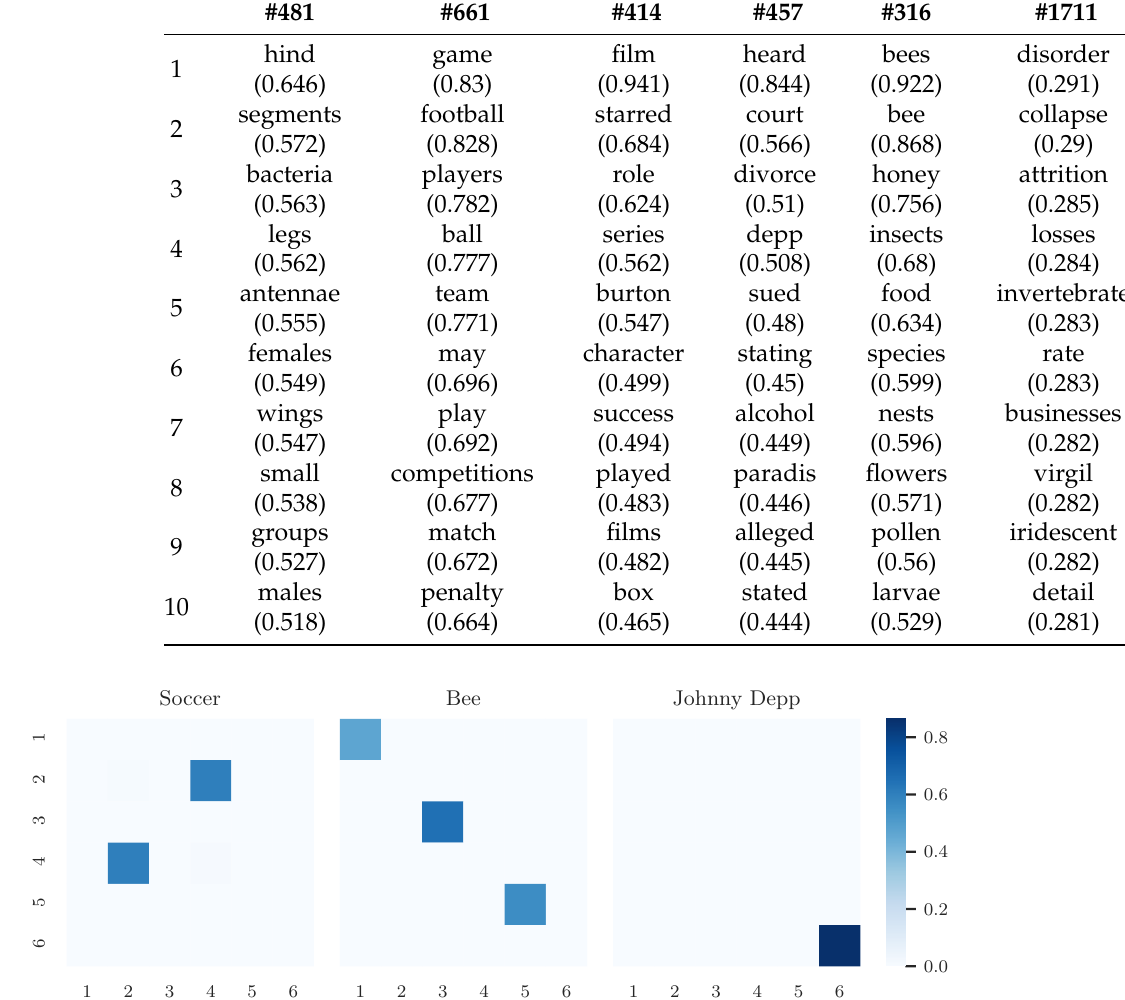
Figure 7. Colored heatmap of affinity tensor R , trained on the Wikipedia data represented as input tensor using multiplica- tive update